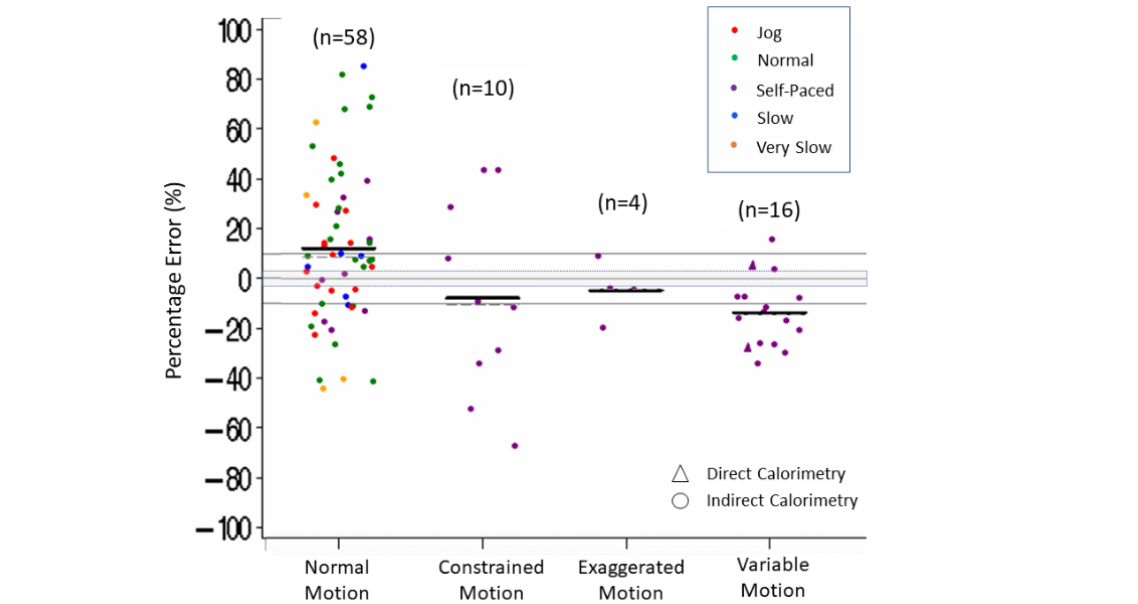
Figure 9. Energy expenditure percentage error in controlled settings. Motion limitations (normal, constrained, exaggerated, variable) by speed (jog, normal, self-paced, slow, very slow). Dark lines indicate mean (horizontal). Dashed lines indicate median (horizontal). Triangles indicate measurement by direct calorimetry. Gray shading indicates ±3% measurement error.